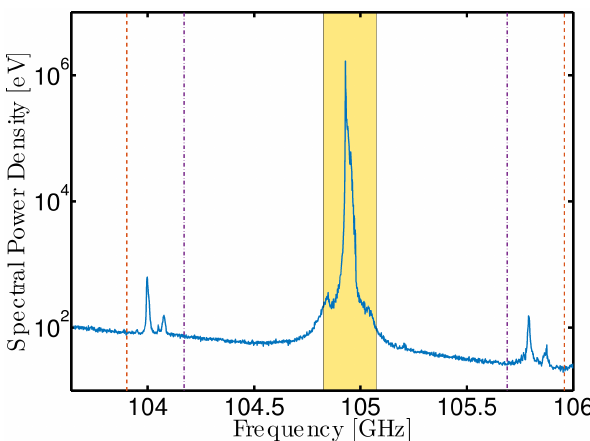
Figure 2. Mean spectrum recorded using the fast acquisition CTS system during a pulse at B t = − 2 . 531T in ASDEX Upgrade discharge #34575. The gyrotron peak is clearly visible slightly below 105 GHz ( ω 0 / (2 π ) = 104 . 93GHz), and is located inside a notch filter stop band, marked by the shaded area, where the calibration giving the spectral power density in eV is rather uncertain. The peaks due to the PDI-generated plasma waves are shifted by 800 − 900MHz, roughly ω LH / (2 π ), relative to the gyrotron peak; both down-shifted and up-shifted peaks are visible in the spectrum. For reference, ( ω 0 ± ω 1 ) / (2 π ) and ( ω 0 ± ω LH ) / (2 π ) from the theory of [8] are plotted as dashed and dashed-dotted lines, respectively; the peaks are located between the lines, as expected